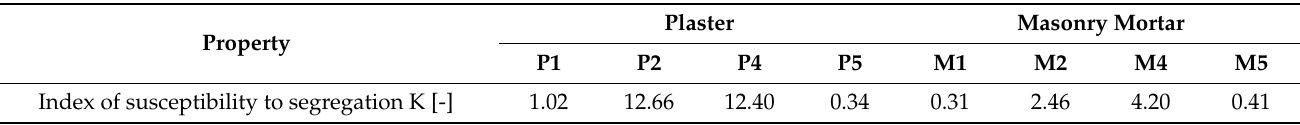
Table 5. Resistance to segregation test